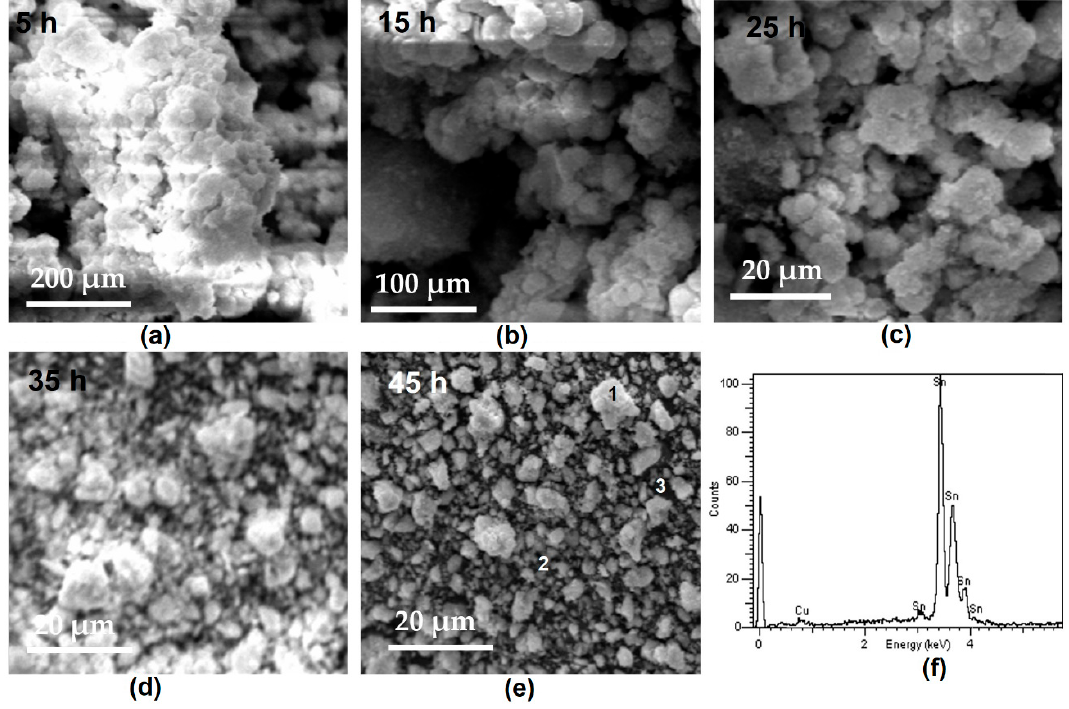
Figure 2. SEM micrograph of Sn-0.7Cu alloy milled for various times. ( a ) 5 h, ( b ) 15 h, ( c ) 25 h, ( d ) 35 h, ( e ) 45 h, and ( f ) energy-dispersive X-ray spectroscopy (EDS) analysis.